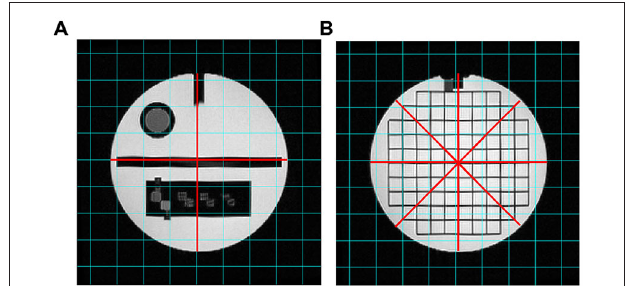
FIGURE 4 | T2-weighted images analyzed for the “Geometric accuracy” test. The red lines indicate the diameters to be measured on slice 5 (A) and slice 12 (B)